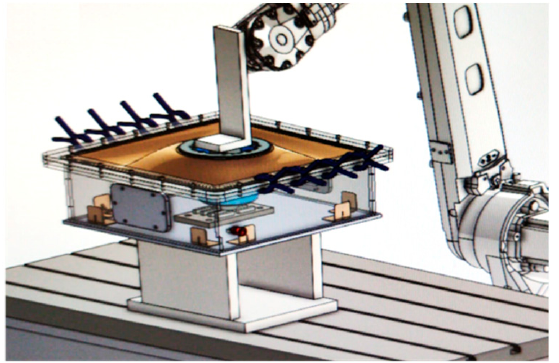
Figure 5. Photograph of the design of the inert chamber.